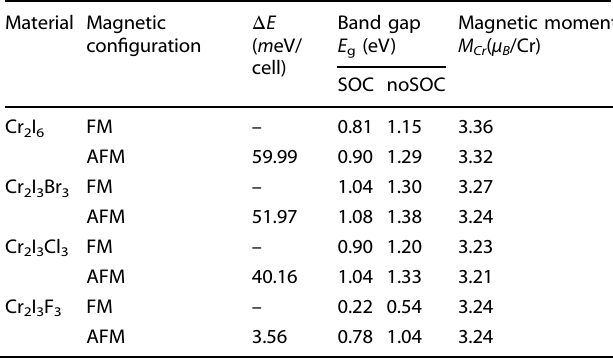
Table 2. Formation energy Δ E coh of 2D Cr 2 I 6 , Janus Cr 2 I 3 Y 3 . System